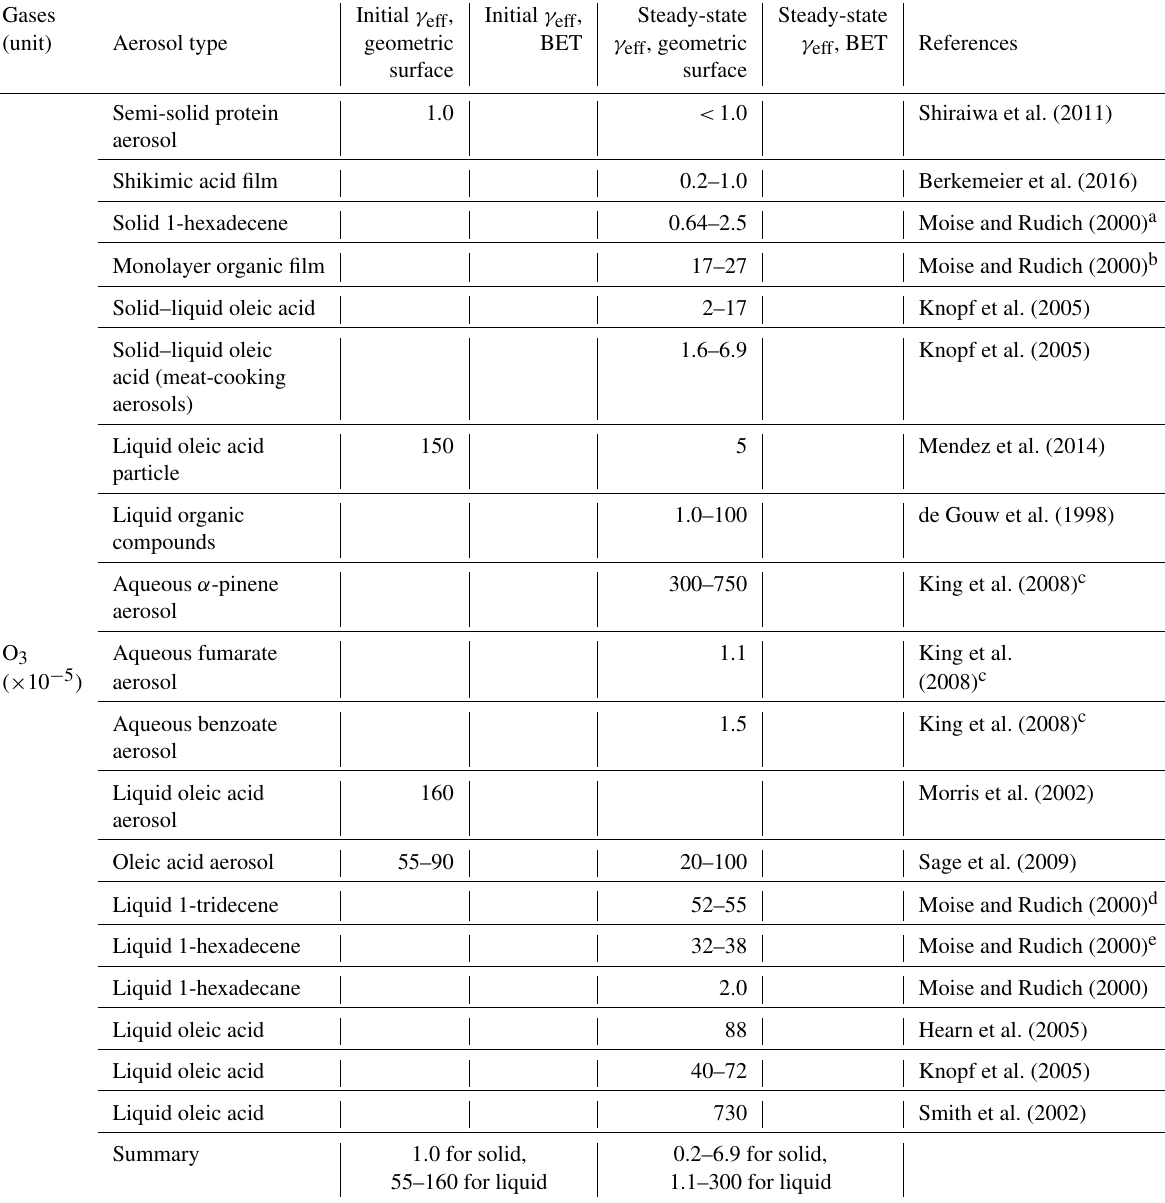
Table A3. Aerosol uptake coefficients ( γ eff ) for reactive gases on organic aerosols observed in laboratory experiments ( T = 298 ± 2K if not specified